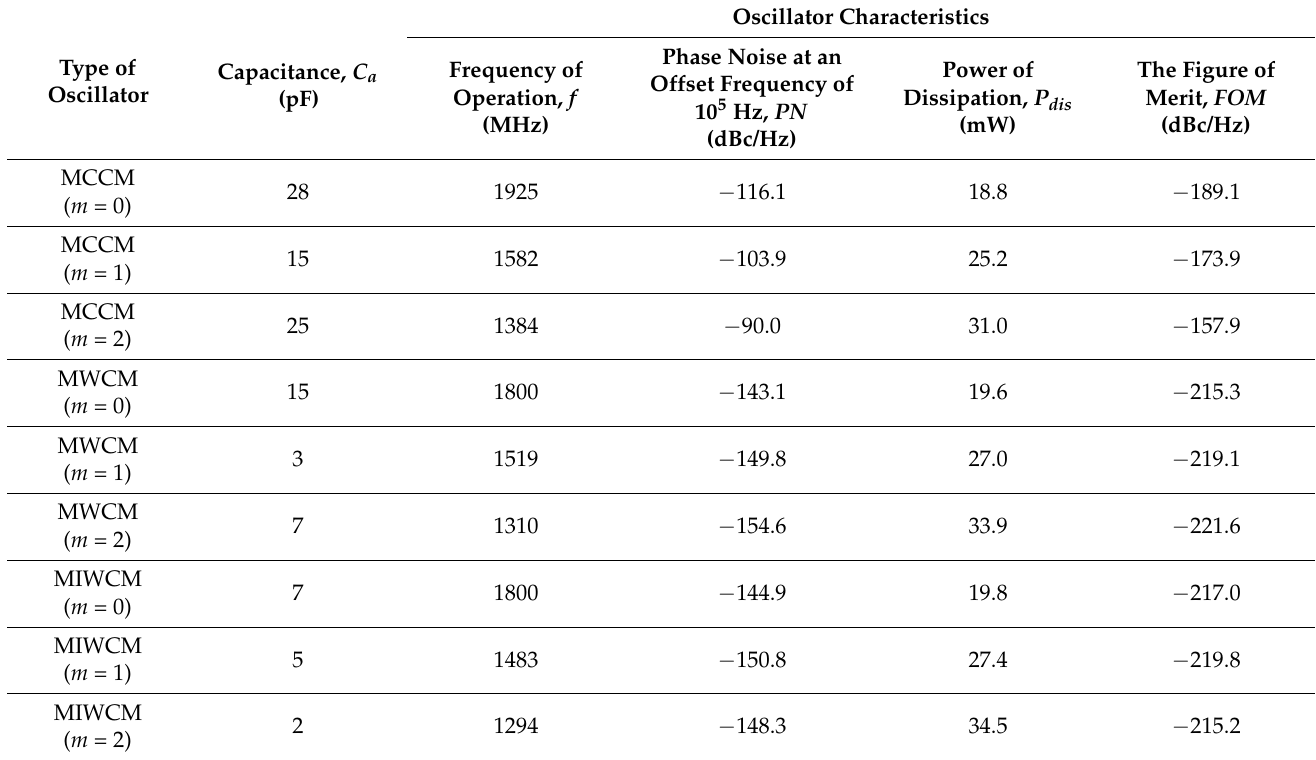
Table 9. Simulated characteristics of different NDR oscillators when R L = 50 Ω .